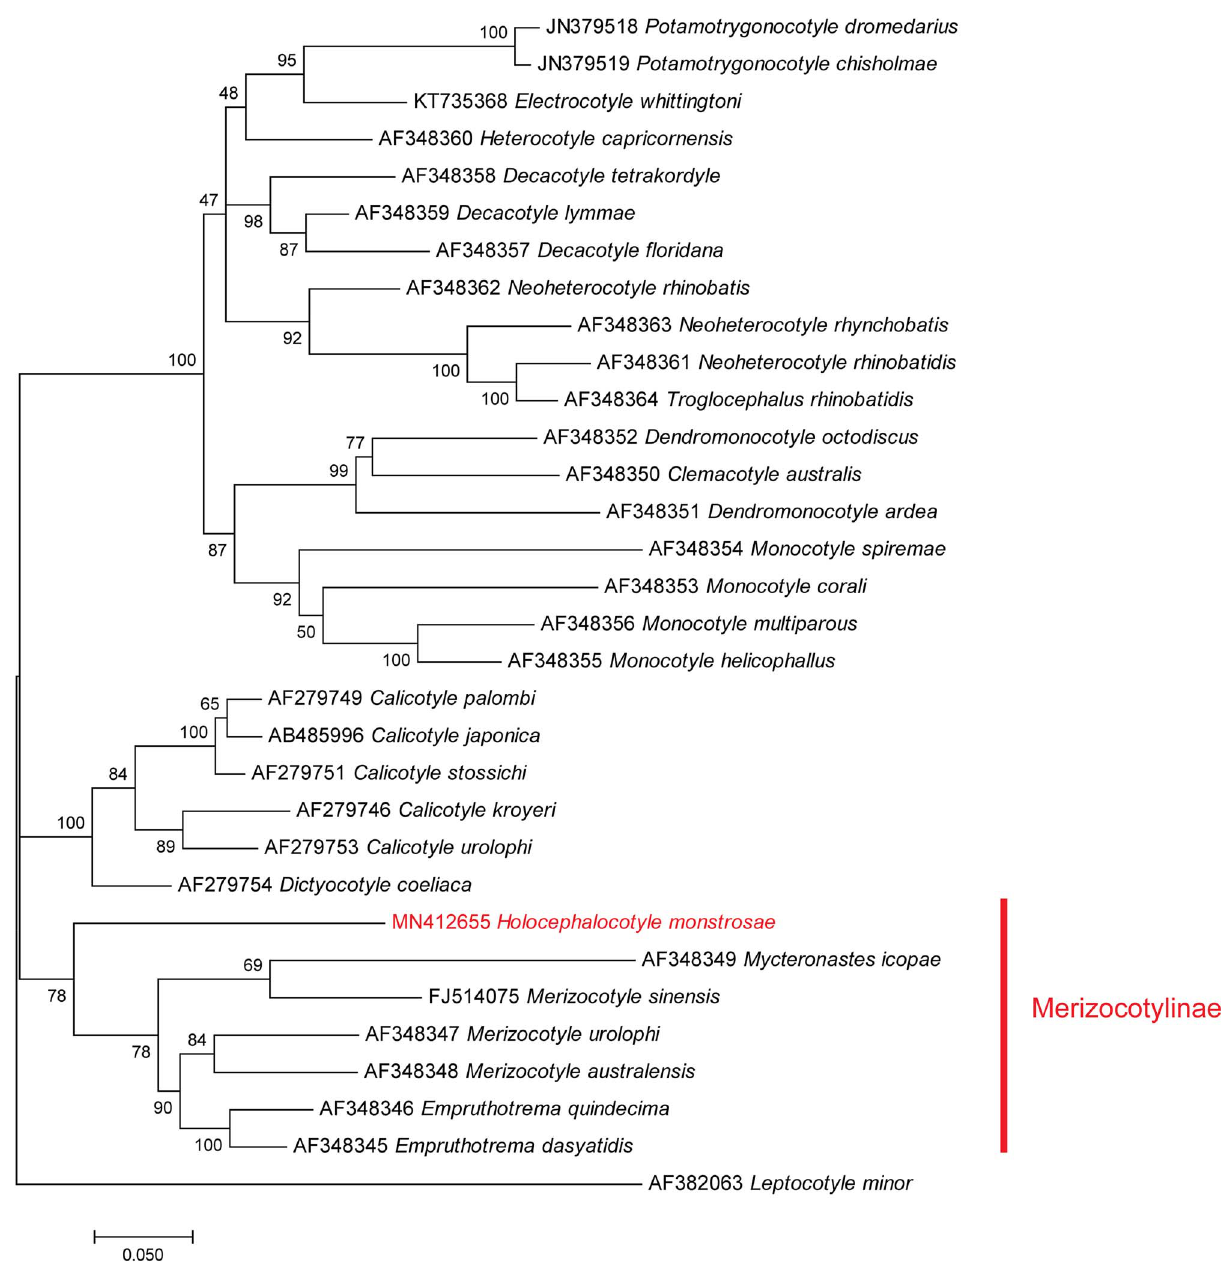
Figure 1. Maximum Likelihood tree of the Monocotylidae based on an analysis of 28S rDNA sequences. Bootstrap percentages with 200